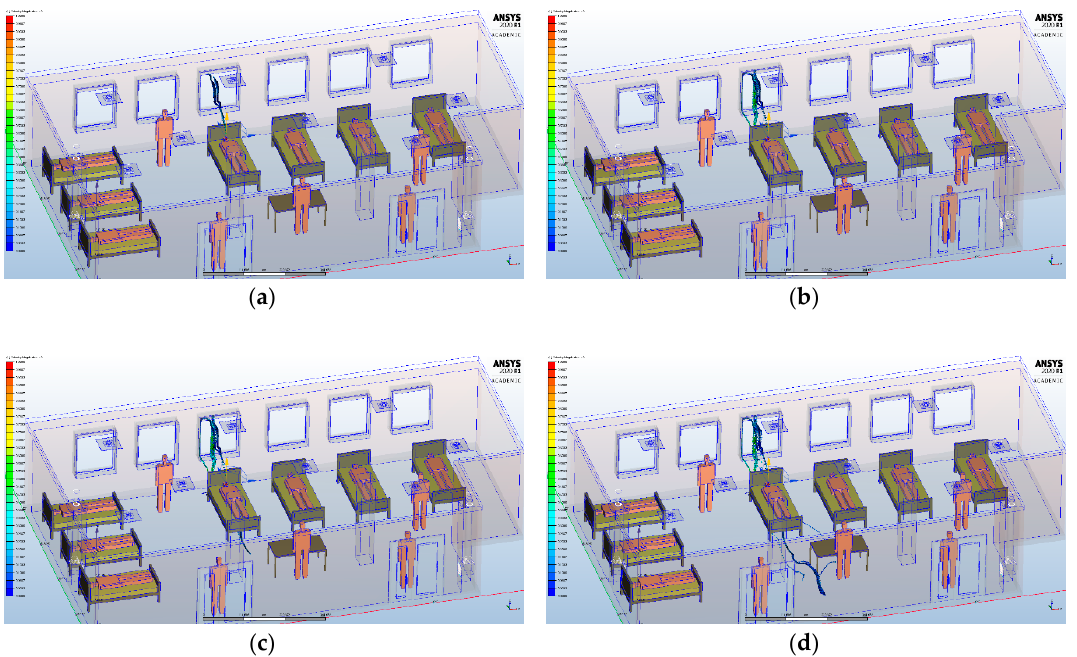
Figure 9. Transient analysis of the lighter particles dispersion carried into the air by buoyancy for HVAC systems, at different time intervals, if the infected patient is in the bed from the middle of the intensive care unit: ( a ) 2 s; ( b ) 3 s; ( c ) 4 s; ( d ) 5 s.